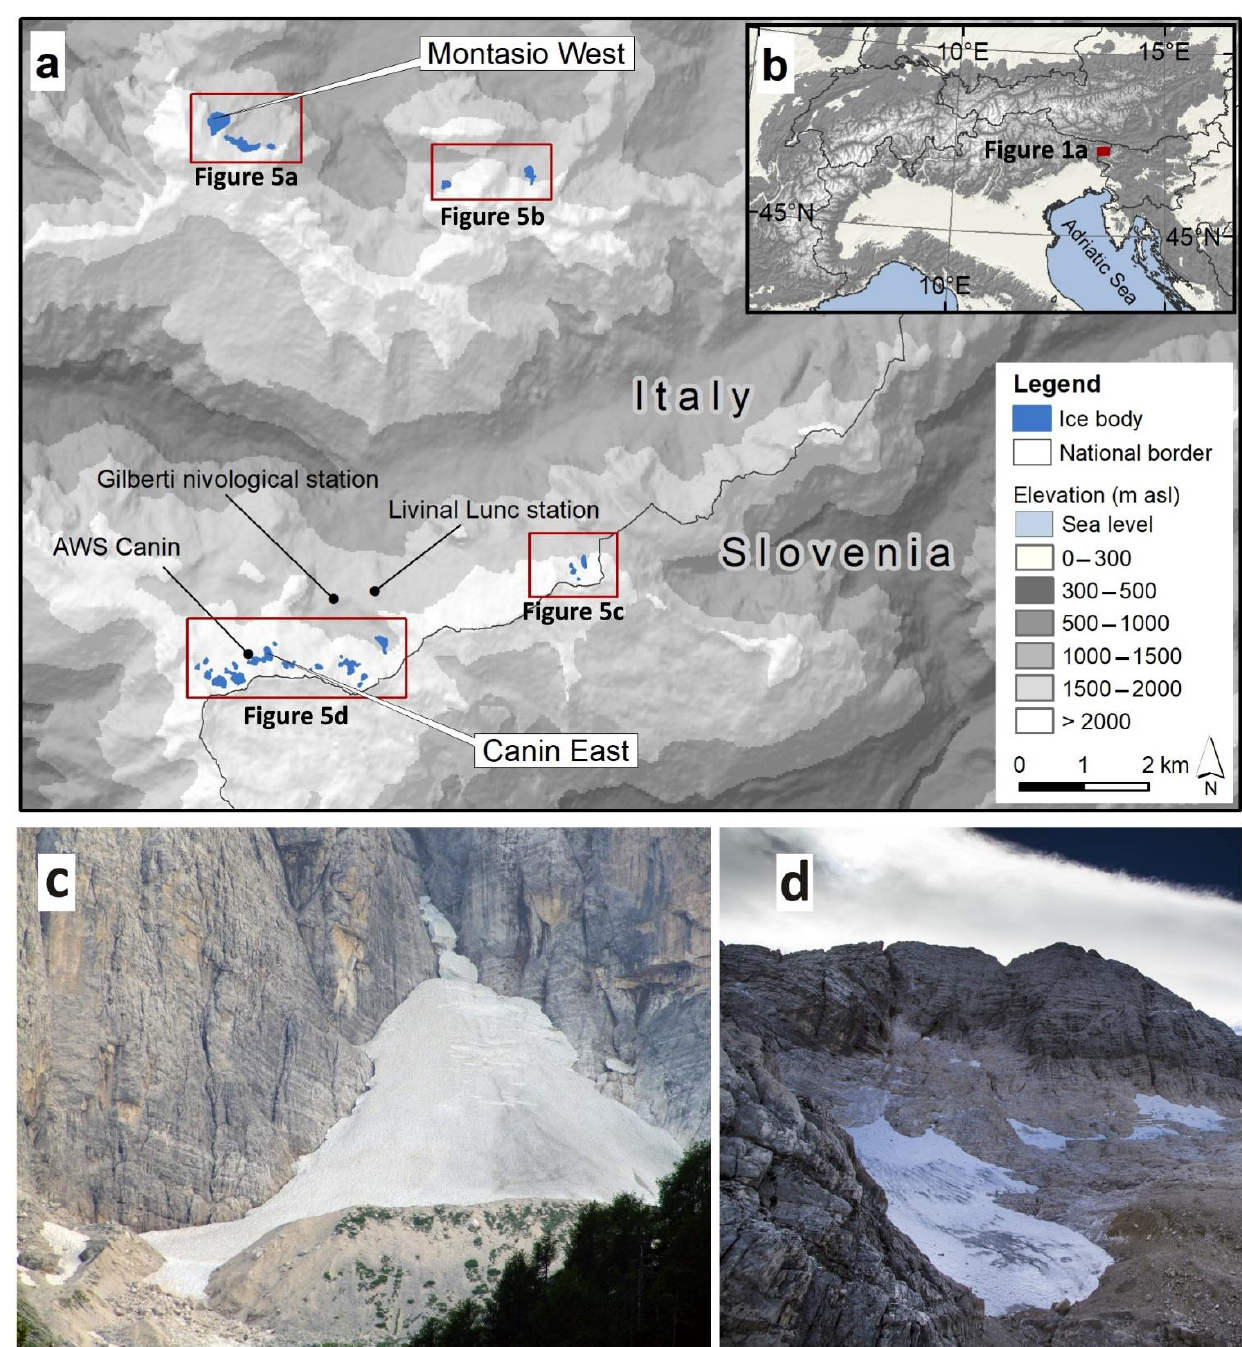
Figure 1. ( a ) Distribution of ice bodies in the Italian Julian Alps. ( b ) Location of the Julian Alps study area. ( c ) Montasio West glacier. ( d ) Canin East glacier ice patch. Photo R.R. Colucci.